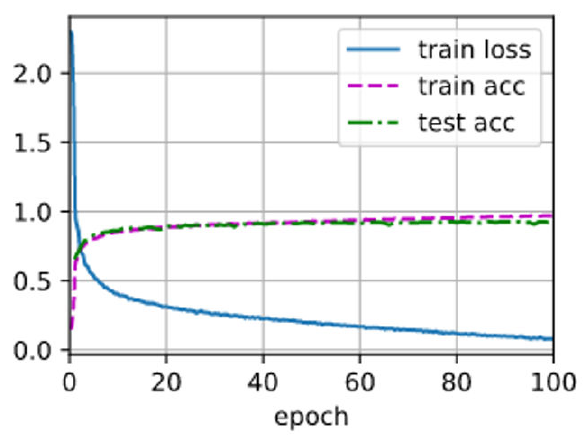
Figure 8. The training process of the model. With 90.9% recognition accuracy, the model works well for underwater acoustic data with strong noise. Since the number of samples of each class varies greatly, we provide a confusion matrix for the recognition result of the proposed model, as shown in Figure 9. Each row of the confusion matrix corresponds to the real label and each column corresponds to the predicted